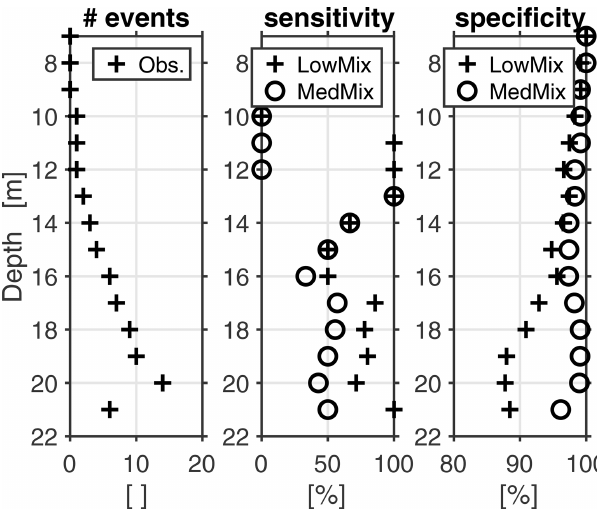
Figure 6. Fidelity of hindcasted hypoxic events (oxygen threshold of 120mmolO 2 m − 3 ) at station Buoy 2a